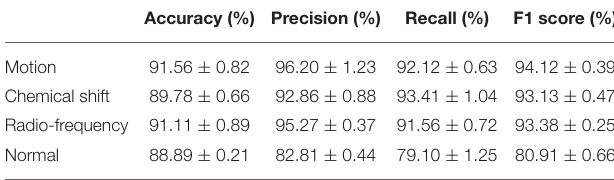
TABLE 2 | Accuracy, precision, recall, F1 score (mean ± stdv).